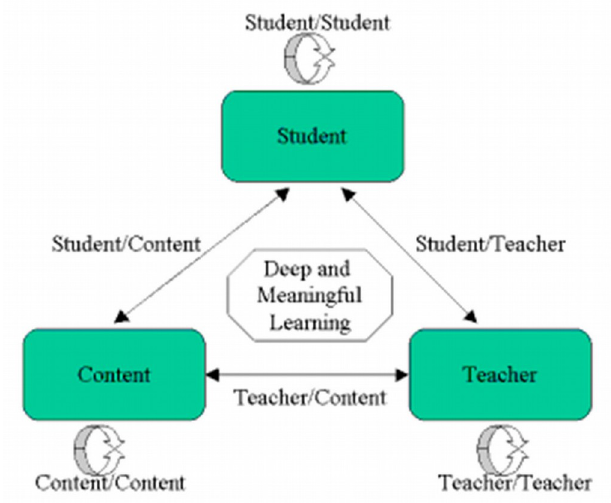
Figure 7. Mode of interactions in distance education (Anderson & Garrison,